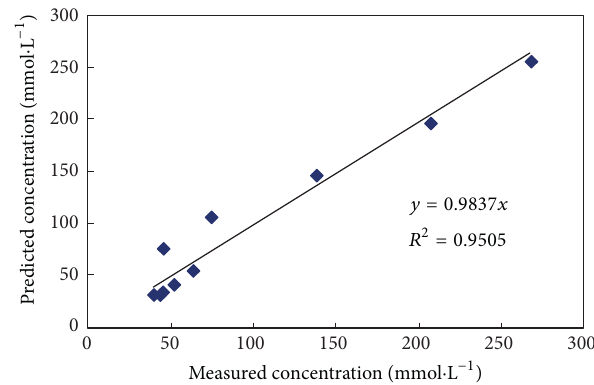
Figure 5: Regression analysis of the measured values and predicted resultsfortheCa 2+ concentrationofthesoilleachateinapenetration experiment.